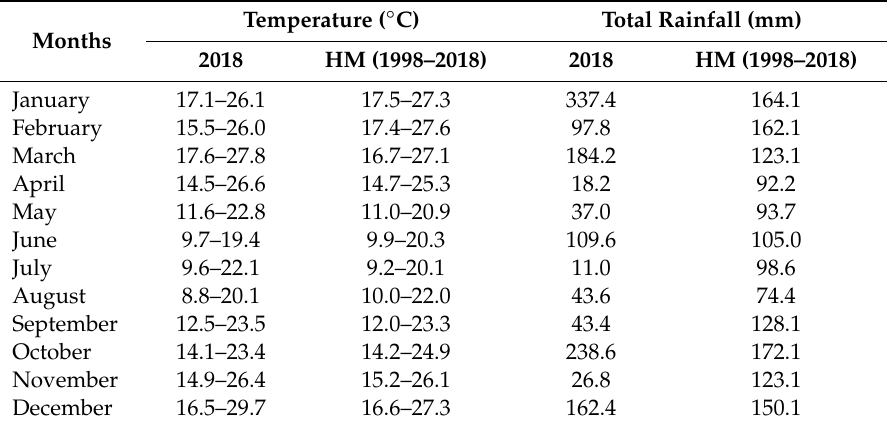
Table 1. Mean minimum–maximum monthly temperature ( ◦ C) and total rainfall (mm) during the experimental period (2018) and historical mean